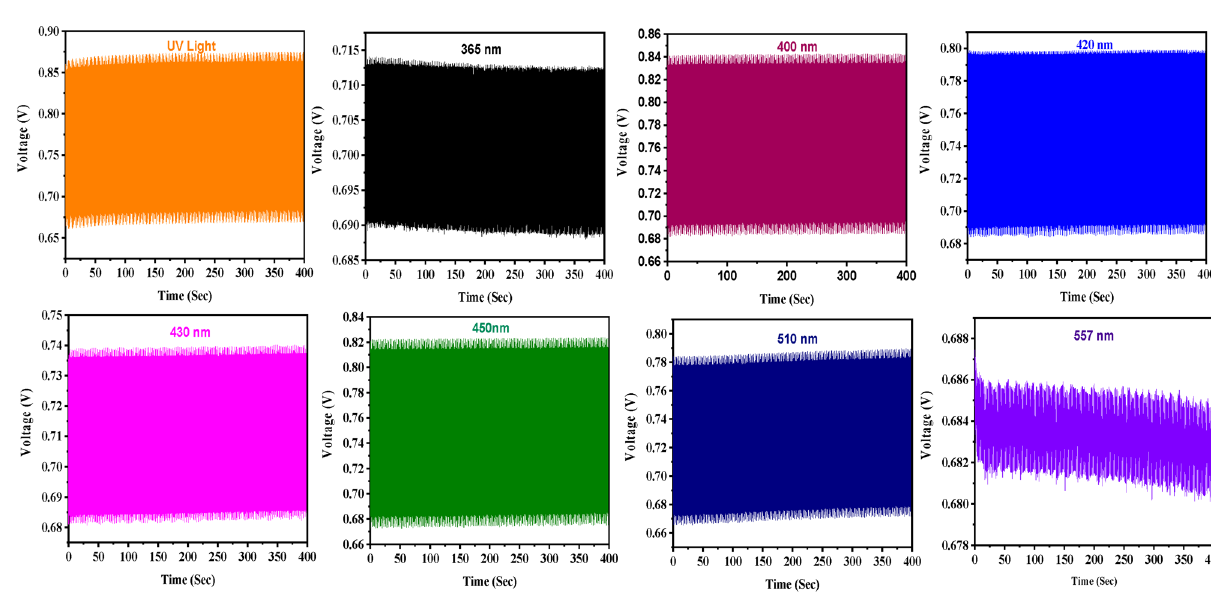
Figure 4. Stability analysis ( a ) perovskite alone, ( b ) NiS/ZnO with perovskite.